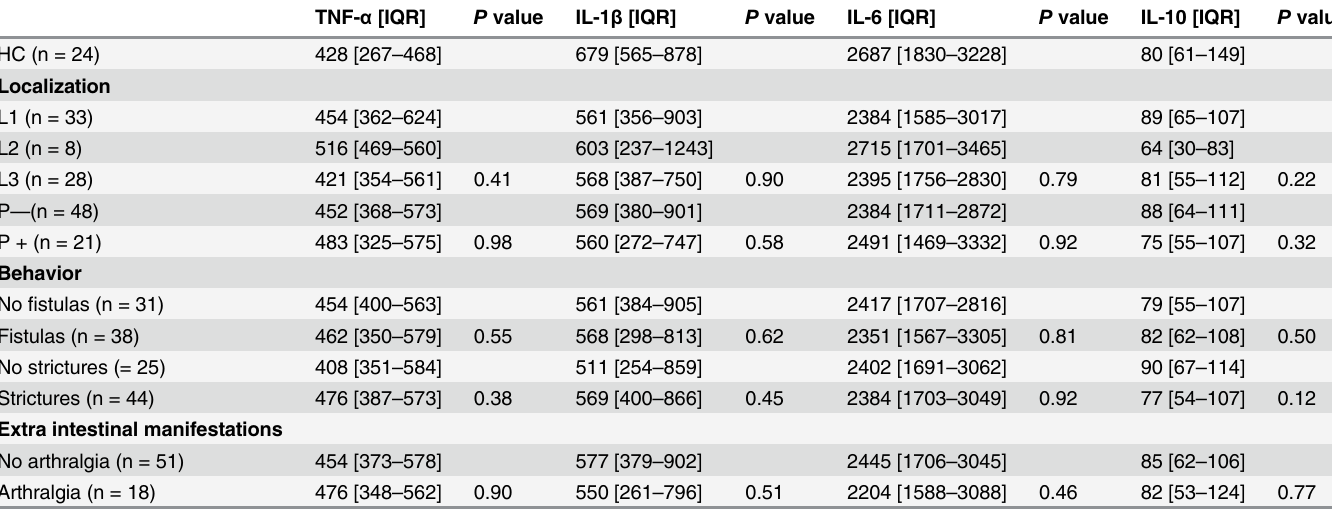
Polymorphisms in the TNF- α promoter region and TNF- α production Fig 2 shows the TNF- α values of patients with various genotypes in the TNF- α promoter region. We found no evidence for an increased TNF- α production in LPS-stimulated whole blood cultures of patients with one or more SNPs in the TNF- α promoter region. The -308A genotype, the most used surrogate marker for a high producer phenotype, showed a median [IQR] TNF- α production of 450 pg/ml [306 – 554] compared to 469 pg/ml [378 – 590] in Table 4. Cytokine production and disease